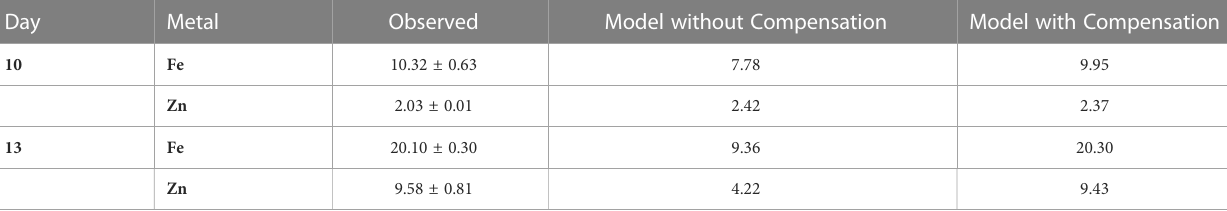
TABLE 3 Fe and Zn in biomass of the wbc19 mutant as observed (± SD) and in the model without and with compensation (as depicted in Figure 2 ). Day